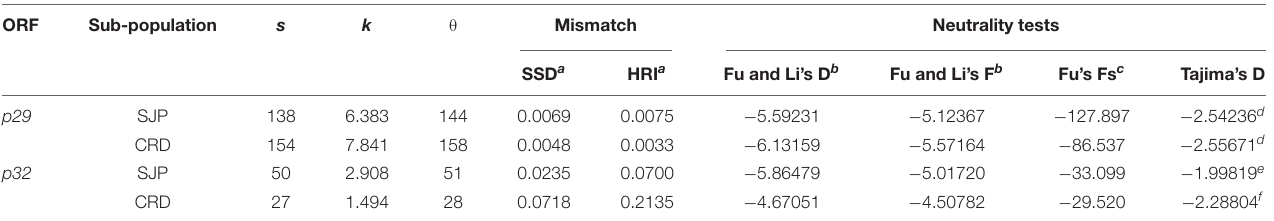
TABLE 8 | Genetic diversity indices, pairwise mismatch distributions, and neutrality tests (Fu and Li’s, Fu’s Fs, and Tajima’s D) based on ORFs p29 (795 nts) and p32 (288 nts, partial) of CiLV-C.